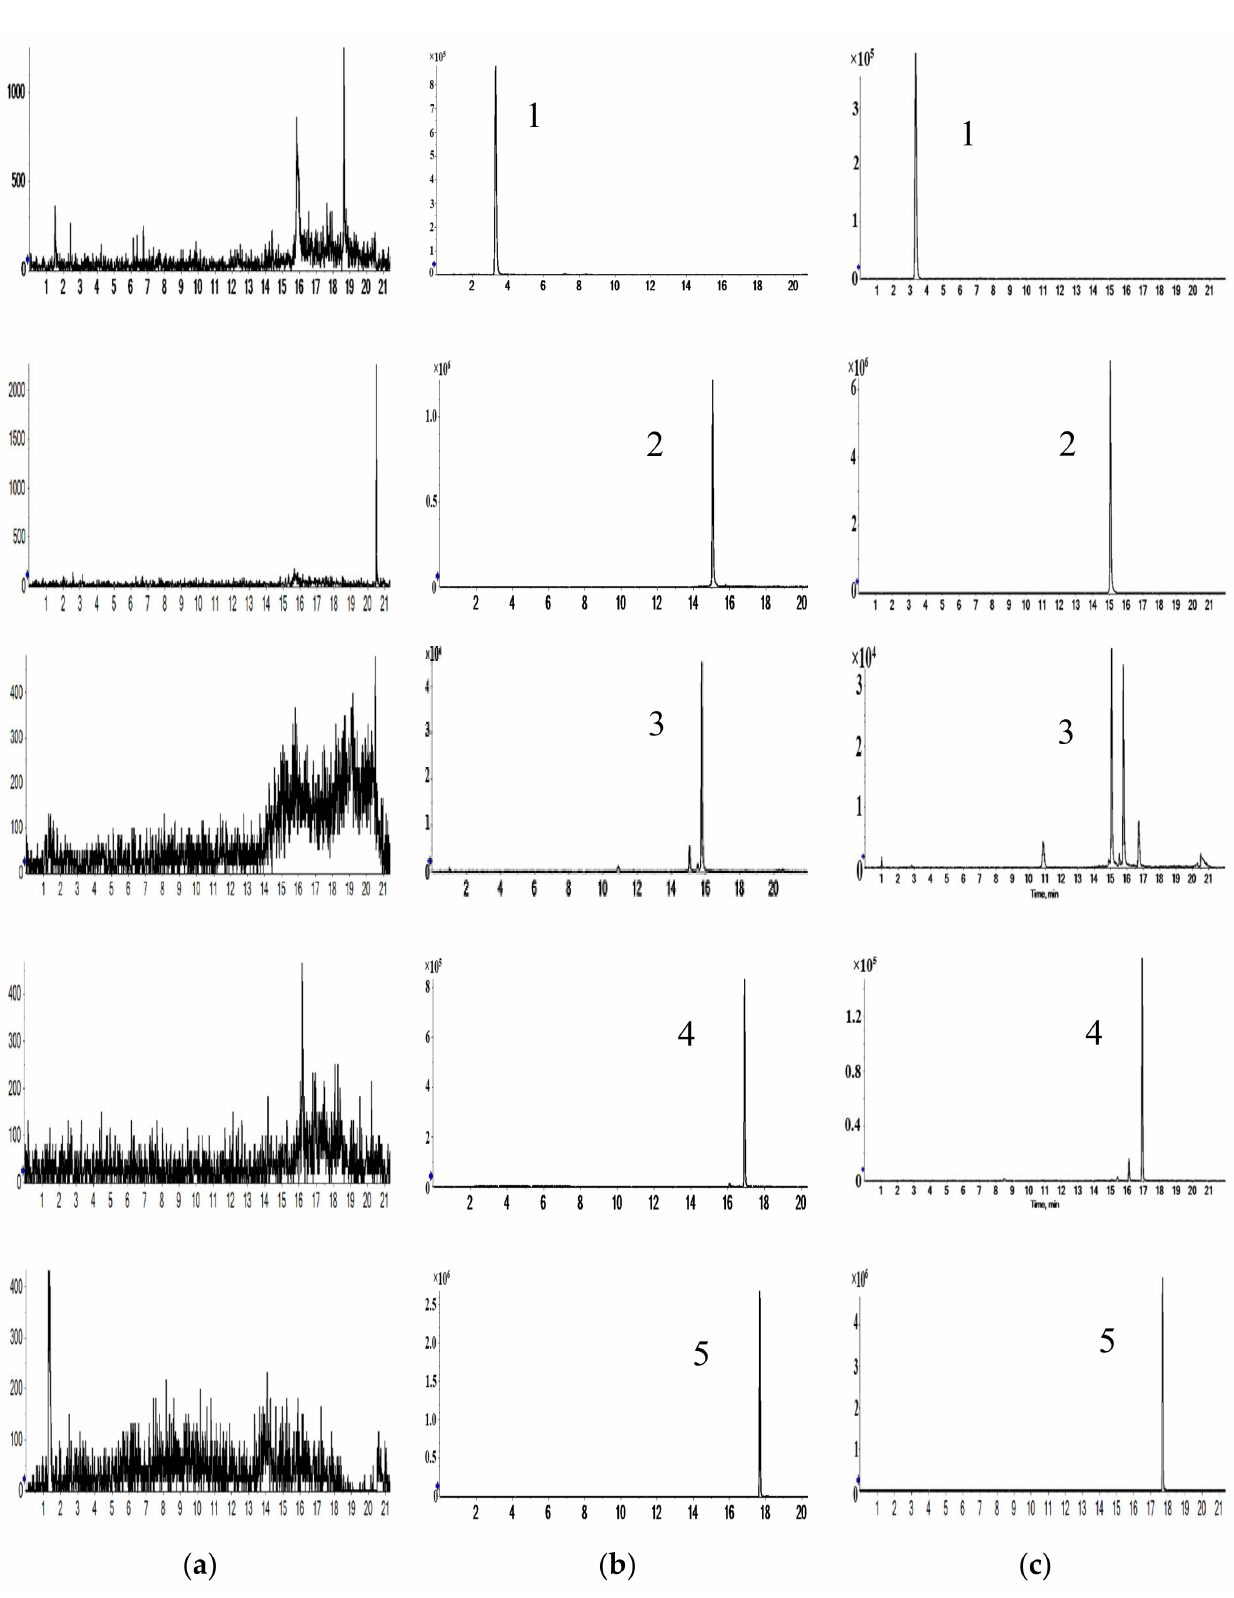
Figure 14. Representative MRM chromatograms of analytes in different samples. ( a ) Blank prostate; ( b ) blank prostate + reference substance+IS; ( c ) prostate samples after oral administration of the aerial parts of G. uralensis for 4 h; (1) puerarin; (2) luteolin; (3) kaempferol; (4) pinocembrin; (5) IS